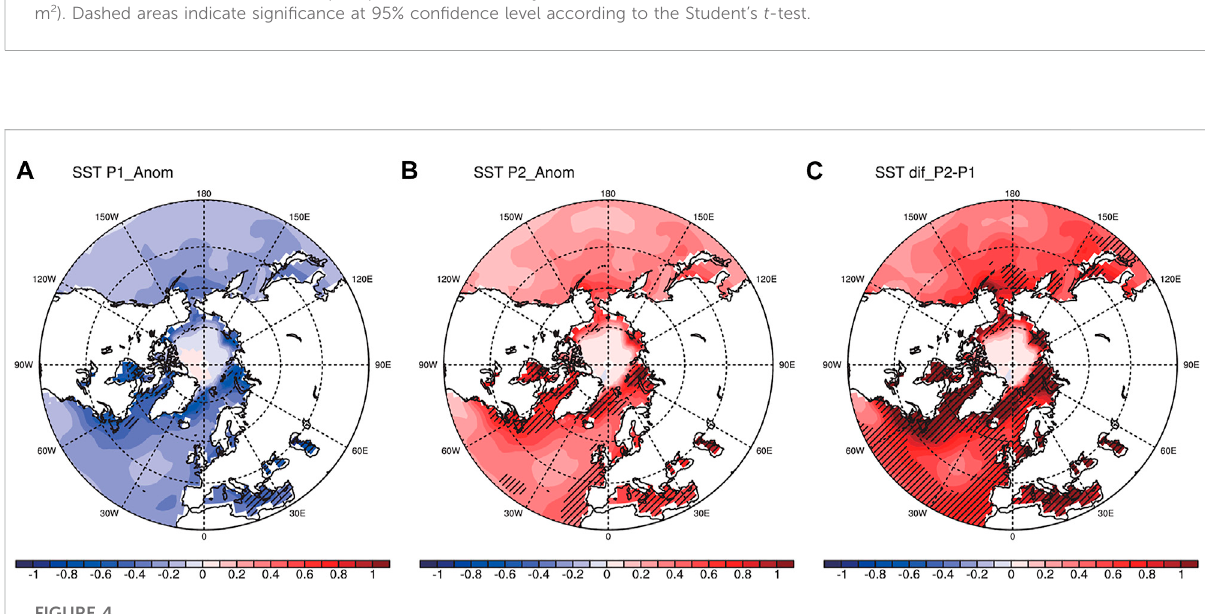
FIGURE 4 DifferencesintermsoftheSSTbetween (A) P1andtheclimatology, (B) P2andtheclimatology,and (C) P2andP1(unit:K).Dashedareasindicate signi fi cance at 95% con fi dence level according to the Student ’ s t